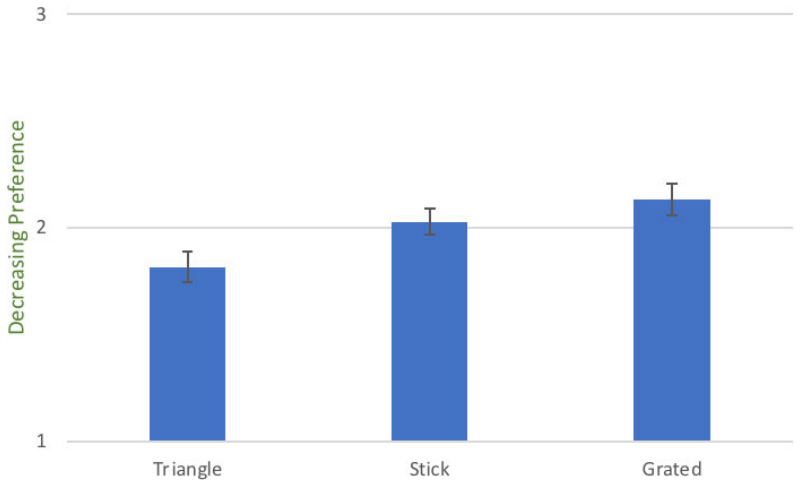
Figure 4. Mean ranking score ± SEM of the three serving styles of daikon on behalf of all the children that participated in the study during the first control session. For ranking data, the evaluation scale used was 1 = most preferred, 2 = second preferred and 3 = least preferred, with the mean value of a highly ranked vegetable to contain the value “1” more times and therefore to have lower score than the least preferred vegetable which contains the value “3” more times. The lowest score (in this case for the triangle ‐ shaped daikon) represents the highest preference on behalf of the children. Similarly, the highest bar represents the least preferred serving style.